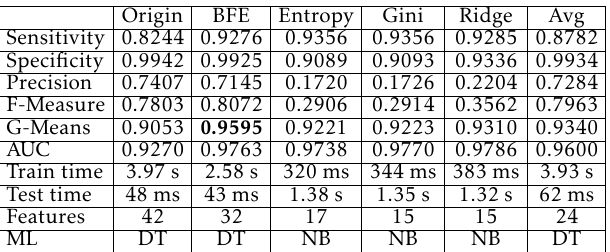
Table 10. Compare CA-BFE with other algorithms on SHELLCODE.